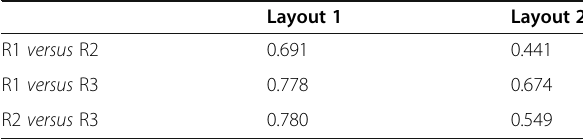
Table 1 Inter-reader agreement for diagnostic confidence as measured by quadratic weighted Cohen ’ s κ for the comparison of the scorings of the three readers (R1, R2, and R3) regarding the two image